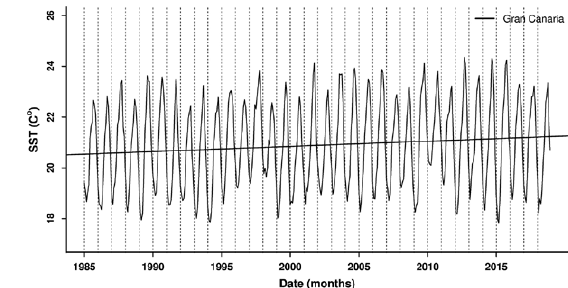
Fig. 2. – Patterns in sea surface water temperatures (SST) from January 1985 to December 2018 at the island of Gran Canaria. The data (monthly L4 product code 010_001) were compiled by the ma- rine segment of the Copernicus European system (www.marine.co- pernicus.eu). Monthly data files were requested using the command line sub-setting and downloading tools, including the corresponding linear trend.